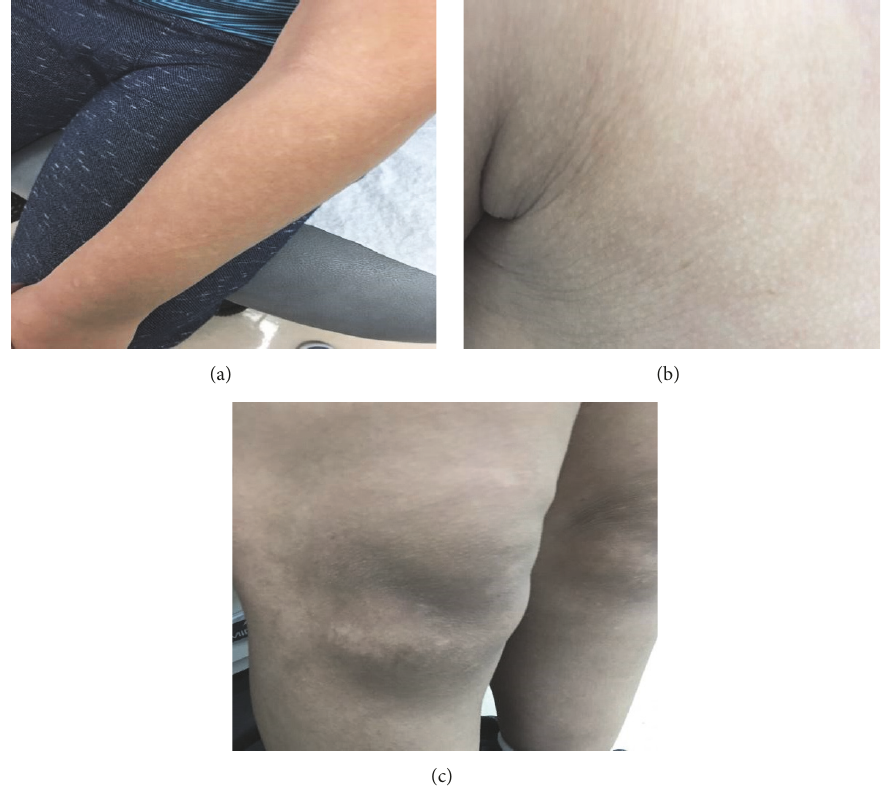
Figure 1: Hypopigmented areas on the (a) upper limb, (b) upper chest, and (c) both